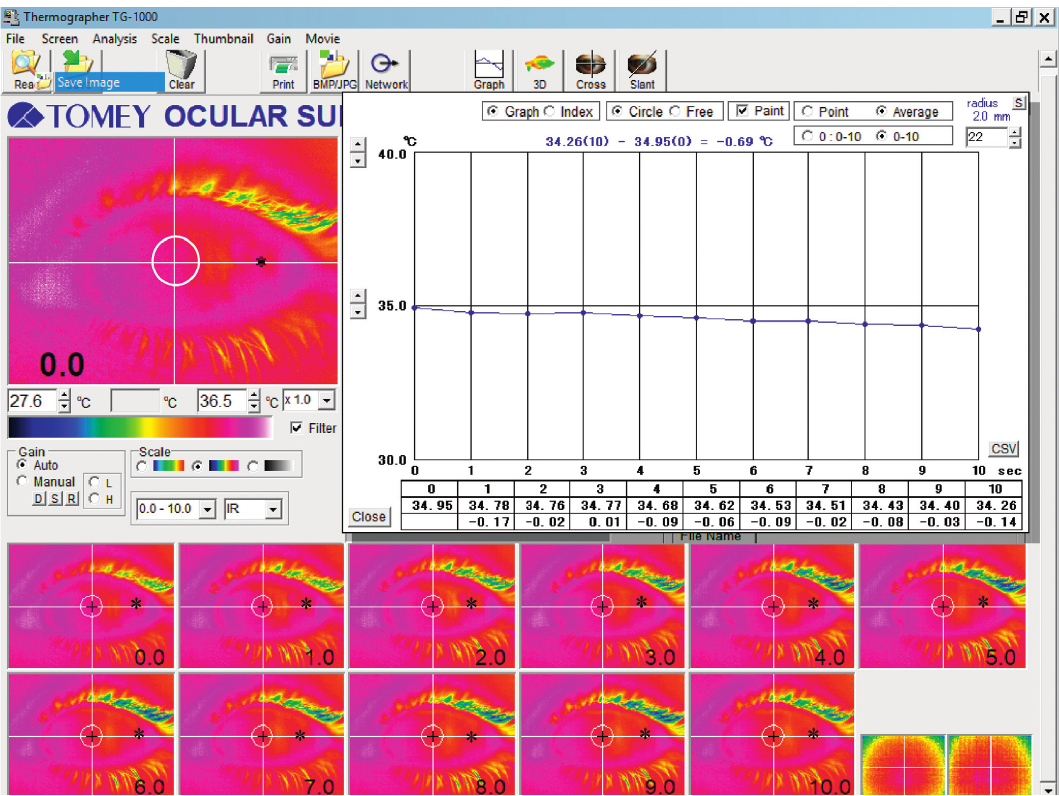
Figure 1: Ocular surface thermography in a keratoconus patient. We extracted mean ocular surface temperature values from the corneal centre (see x) and 2mm from the corneal centre nasally, temporally, superiorly, and inferiorly during 10 seconds of sustained eye opening after blinking (crossing of the white circle and the white lines). Data on ocular surface temperature conjunctivally, 8mm temporally, from the corneal centre ( ∗ ) were also